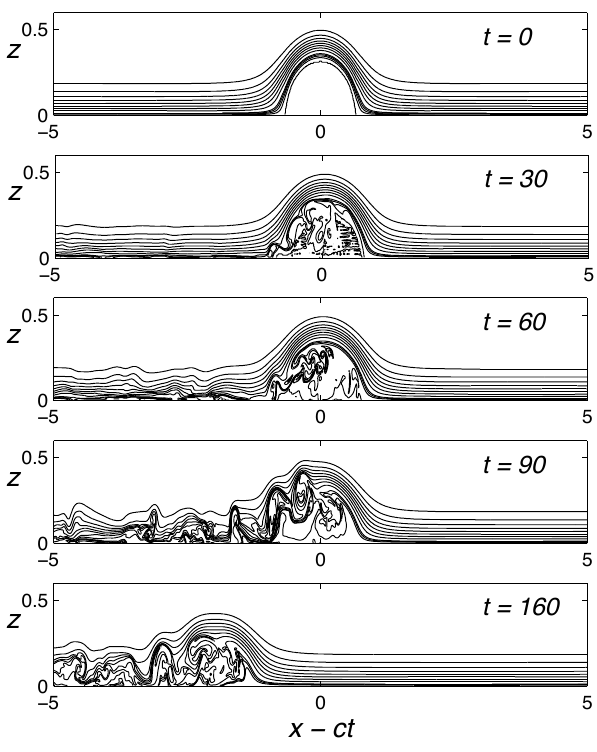
Fig. 17. Evolution of the largest stagnant-core DJL solution found for λ = 8 and s c = 1 at c = 0 . 45. Contours of s are shown at intervals of 0.1 for s ≤ 0 . 9 and 0.025 for s > 0 . 9. Note that only the lower portion of the domain is